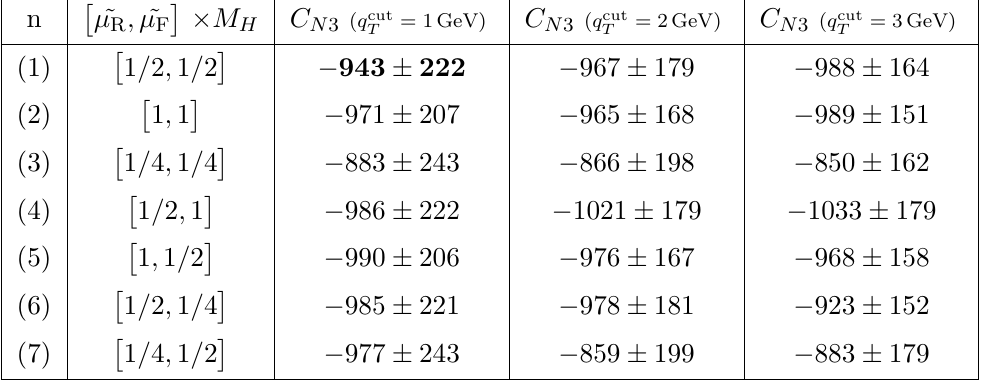
as shown in (cid:12)gure 2 for T =1 GeV) which T